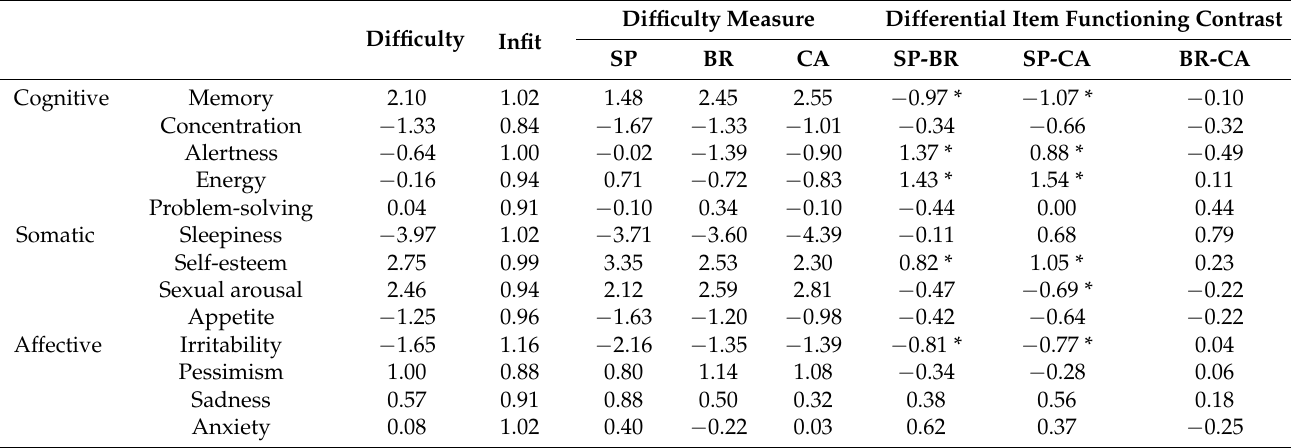
Table 2. Item difficulty, fit measures, and differential item functioning of subscales (MRhI—13 items).